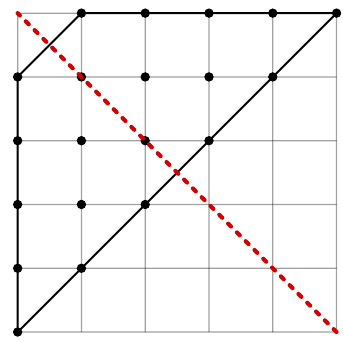
Figure 15. When ZPPs are deformed, additional intersections are added in pairs. We show the corresponding bifundamental fields in the mother theory.